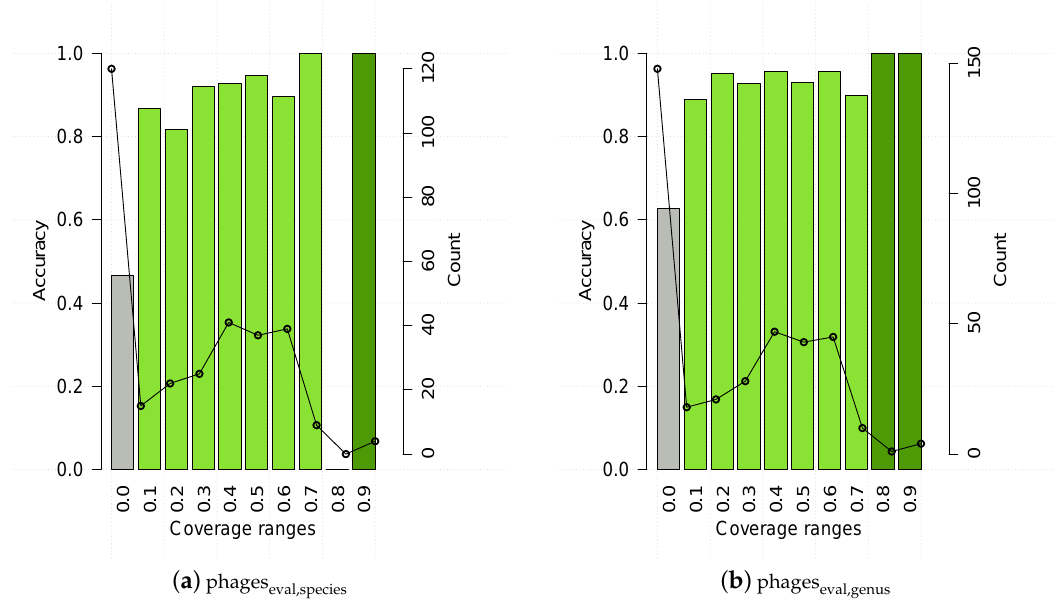
Figure 4. HostPhinder’s accuracy (bar) and prediction counts (line) on phages ranges. The values displayed on the x axis are the lower limit of that range. With exception of the last bin which includes all entries with coverage >0.9, all ranges are right-closed with upper limit x + 0.1. Poorly reliable results are in grey, while reliable and highly reliable results are in green and dark green respectively. Results on HostPhinder’s web server [1] are displayed using the same colour